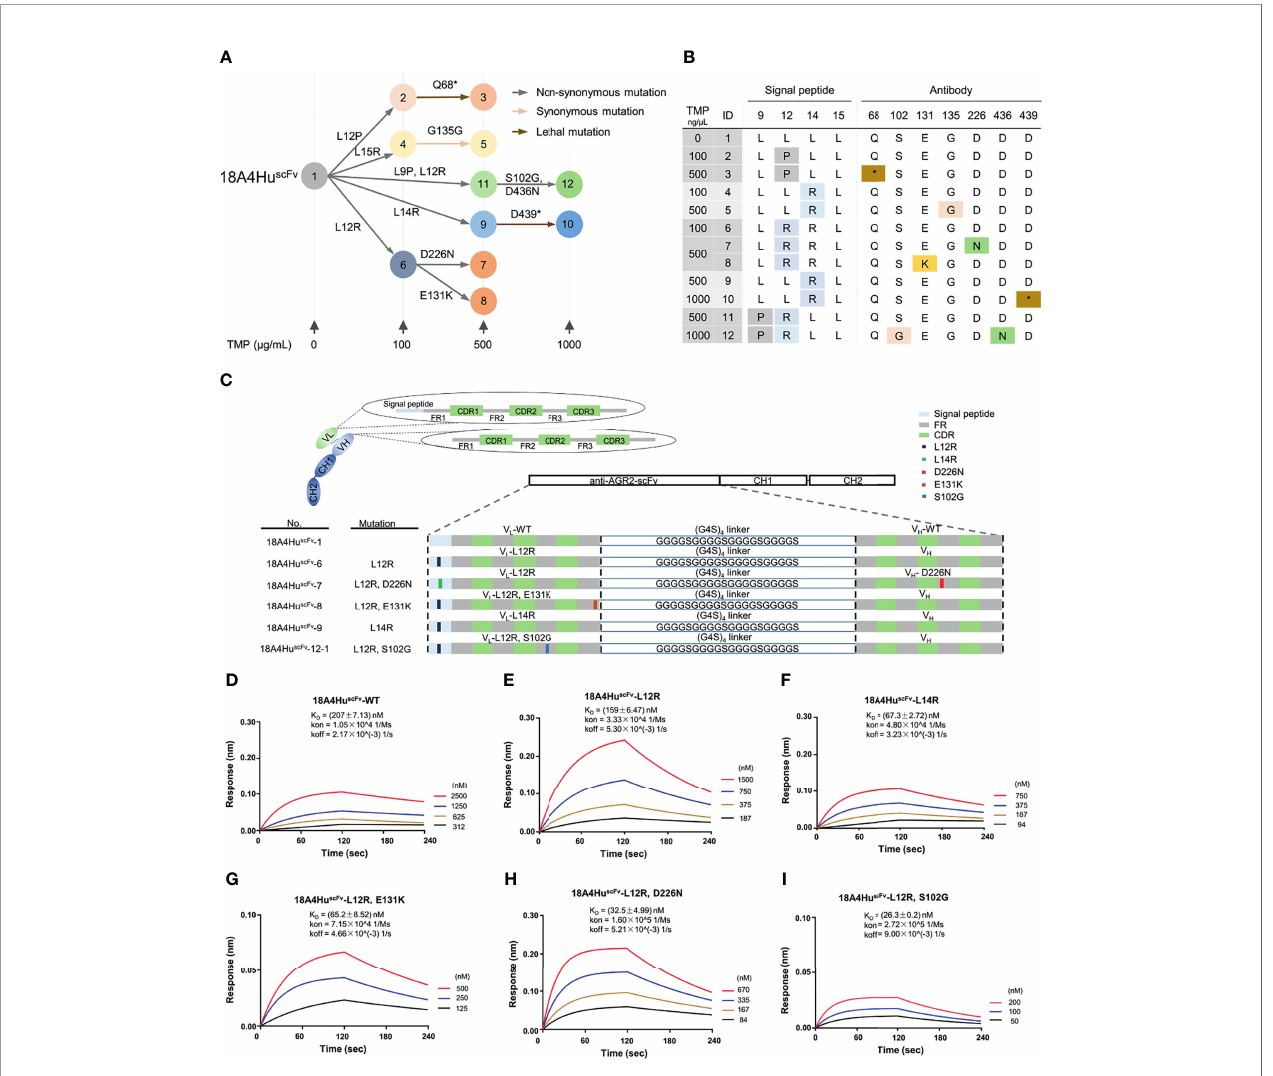
FIGURE 3 | Improved binding af fi nity of 18A4Hu scFv to its target protein by EASINESS. (A) Plausible evolution trajectories of 18A4Hu scFv by EASINESS in gradient concentrations of TMP from 0 to 1,000 ( m g/ml). (B) These mutated sites of 18A4Hu scFv located in the signal peptide or antibody backbone. The red star indicates stop codon. (C) The location of mutated residues from fi ve variants in different domains of 18A4Hu scFv . (D – I) Biolayer interferometry (BLI) assays for measuring the binding af fi nity to AGR2 of select 18A4Hu scFv